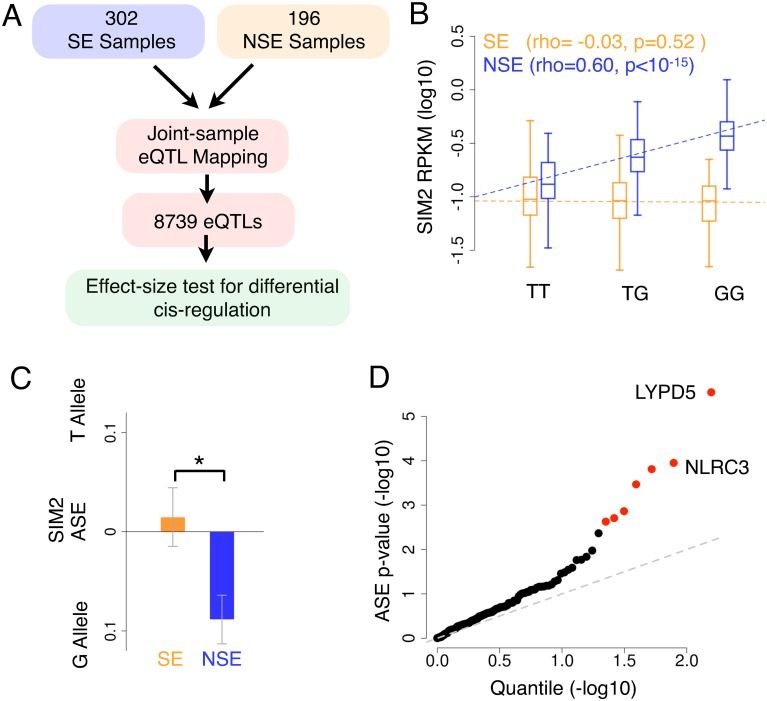
Differential cis-eQTL mapping and validation with ASE.(A) Outline of our approach to mapping differential cis-regulation. (B) The expression of SIM2 for each exposure-type after segregation by genotype at the eQTL (rs2248813). P-values are from the asymptotic approximation of the Spearman correlation (rho). (C) ASE validation of the SIM2 result for individuals heterozygous at the eQTL. The allele on the y-axis indicates the allele at the eQTL (see x-axis of panel B), and the ASE directionalities were phased based on these alleles. * indicates p-value < 0.05 by t-test. (D) QQ plot of each tested gene after combining the effect size test and the differential ASE test. Red indicates the gene had a significant GxE expression interaction with a SNP (FDR < 0.05, Benjamini-Hochberg).